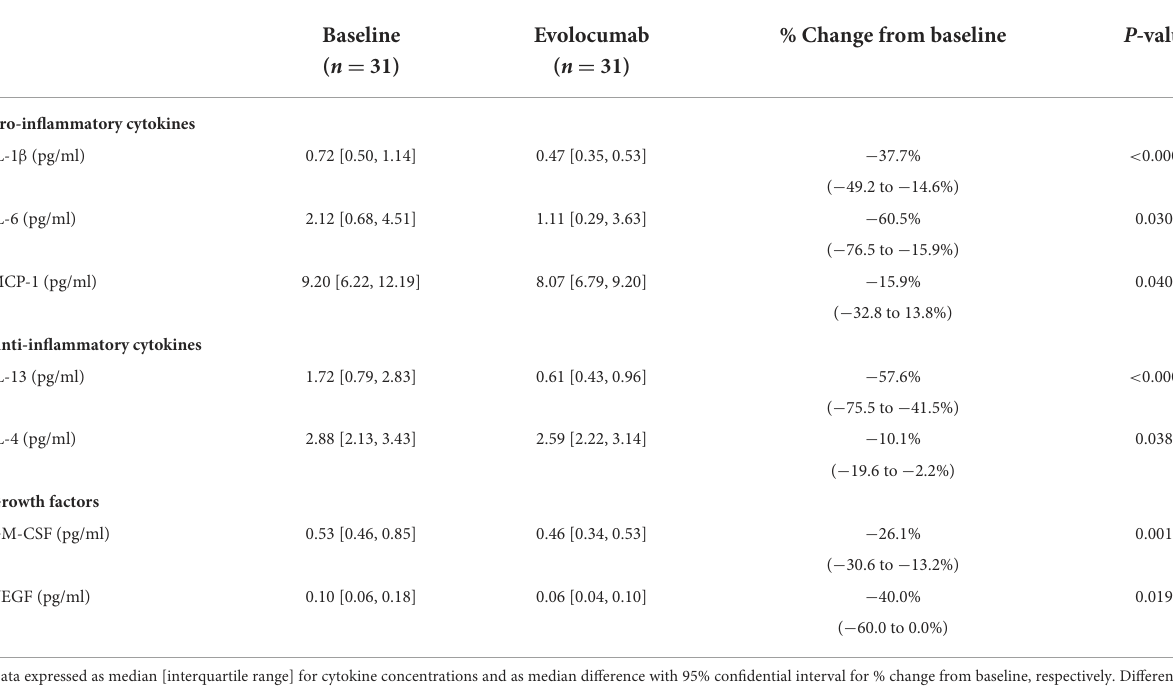
TABLE 3 Concentrations and percentage changes of differentially expressed cytokines.